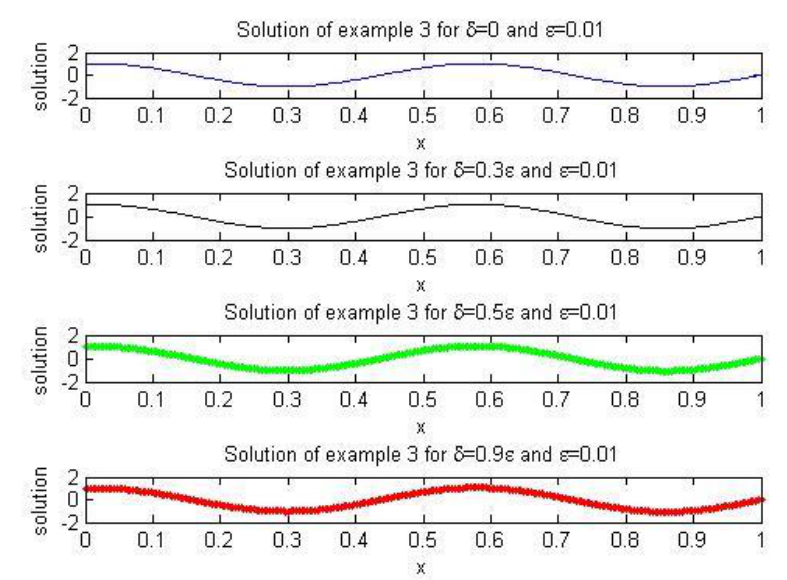
Figure 3. Numerical solution of Example 3 for different values of 𝜺 and